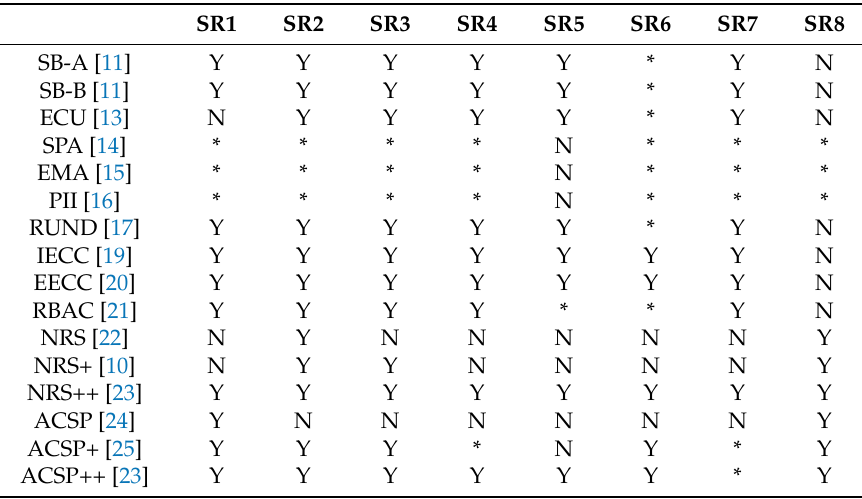
Table 4. Comparison of the Security